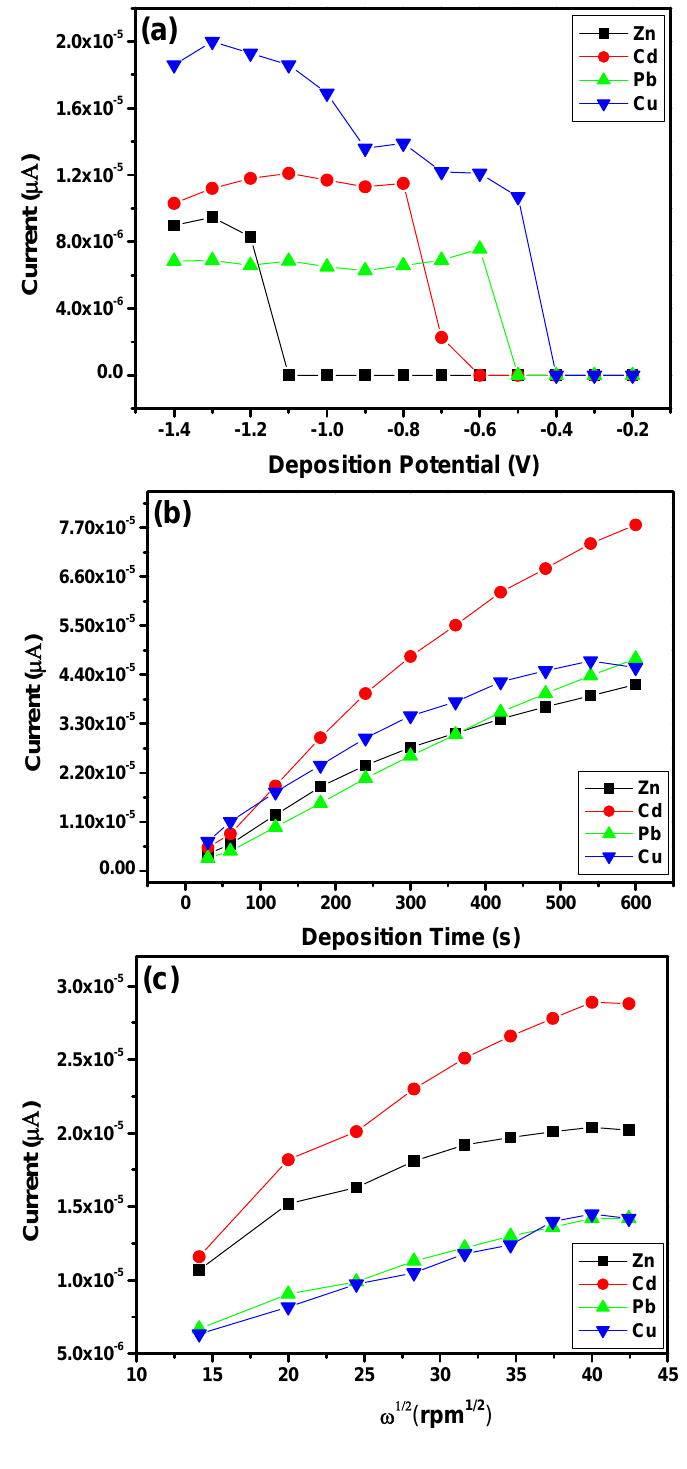
Figure 7. Effect of (a) deposition potential, (b) deposition time and (c) rotation speed on the stripping peak current of Zn 2+ , Cd 2+ , Pb 2+ and Cu 2+ on a Nafion-G mercury film electrode in 0.1 M acetate buffer (pH